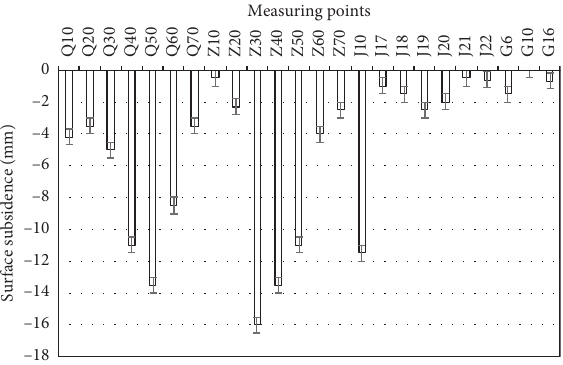
Figure 12: Surface subsidence monitor at the working